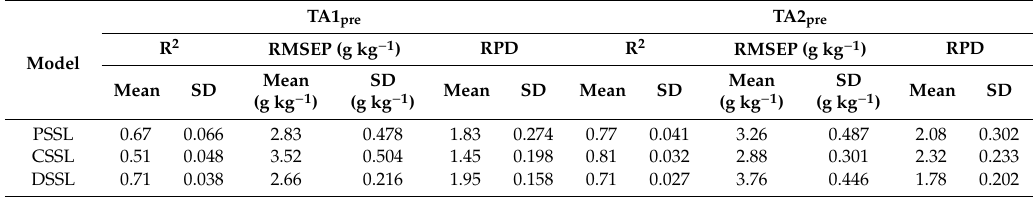
Table 3. Statistical results of prediction performance of the di ff erent scale SSL models. RMSEP, root mean square error of prediction; RPD, residual predictive derivation; SD, standard deviation.